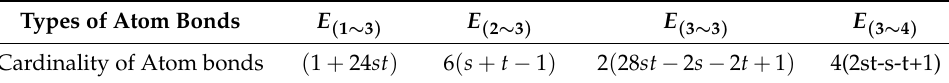
Table 3. Atom-bonds partition of MOF ( s,t )